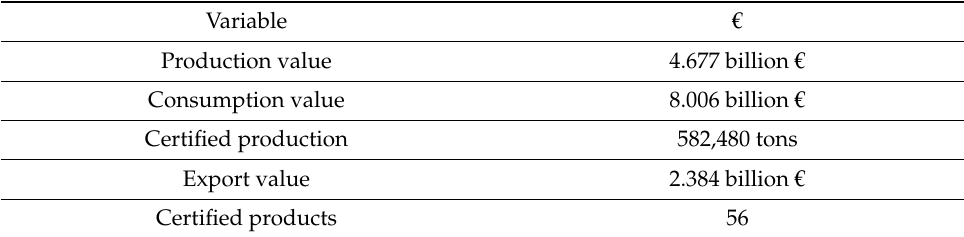
Table 2. Economic data of the GI Cheese